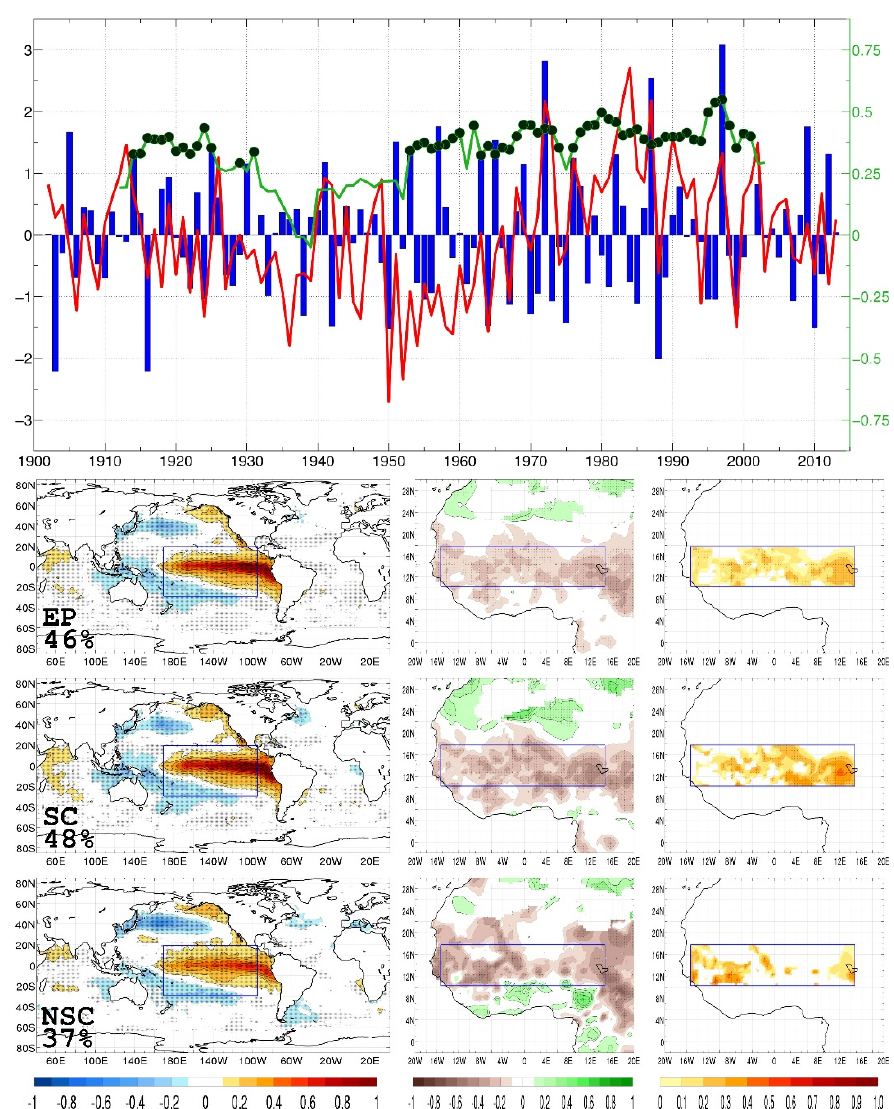
Figure 1. ( Top Panel ) Expansion coefficients of the leading MCA mode calculated between the anomalies of tropical Pacific SST (blue bars, left axis) and the anomalous Sahelian rainfall (red line, left axis) in JAS. Superimposed, the 21-year centered moving correlation windows (green line, right axis) and significant correlation (black filled circles) between both expansion coefficients; ( Bottom Panels ): ( First ) Regression maps of the SST expansion coefficient of the leading MCA mode onto the SST (left) and rainfall (center). Correlation maps (right) between the cross validated hindcast of rainfall performed only with the leading MCA mode. The whole time period is used for the analysis. ( Second ) As (first) but using the years corresponding to the center of the significant correlation windows (green dots in the green curve). ( Third ) As (first) and (second) but using the years corresponding to the center of the non-significant correlation windows. The percentage of squared covariance fraction is indicated in the left bottom corner of the figure.